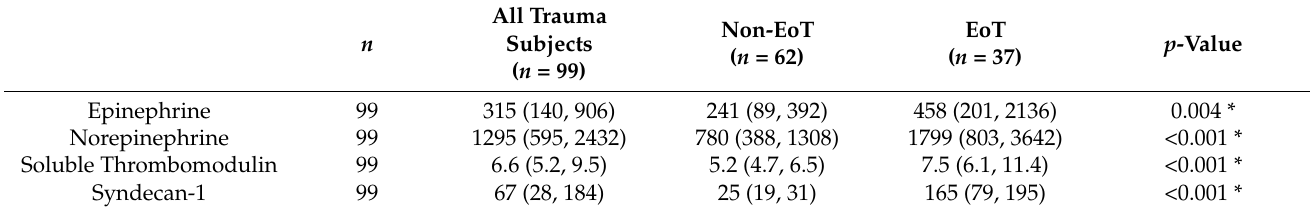
Table 2. Plasma enzyme linked immunosorbent assay results presented as median